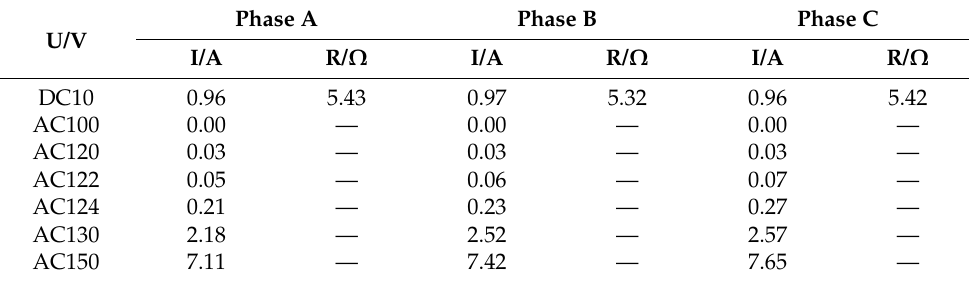
Table 4. Dielectric loss and capacitance test results.